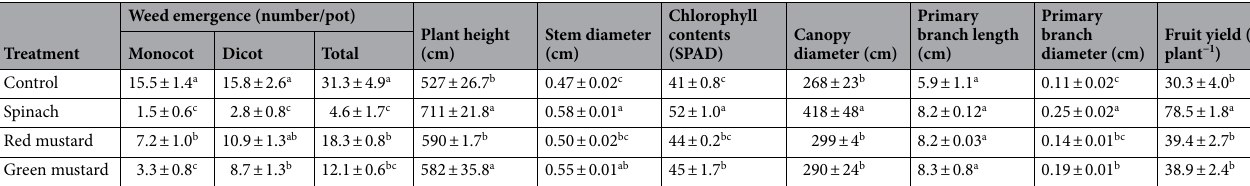
Table 2. Effect of different green manures on weed emergence and pepper performance a . a Weed emergence was collected before pepper transplanting, pepper growth traits were determined at the end of the experiment while fruit yield represents three fruit pickings periods. Mean values followed by different letter (s) in a column represent significant differences at p ≤ 0.05, DMRT